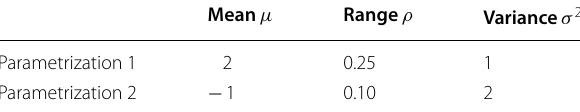
Table 1 Parametrizations of two Gaussian